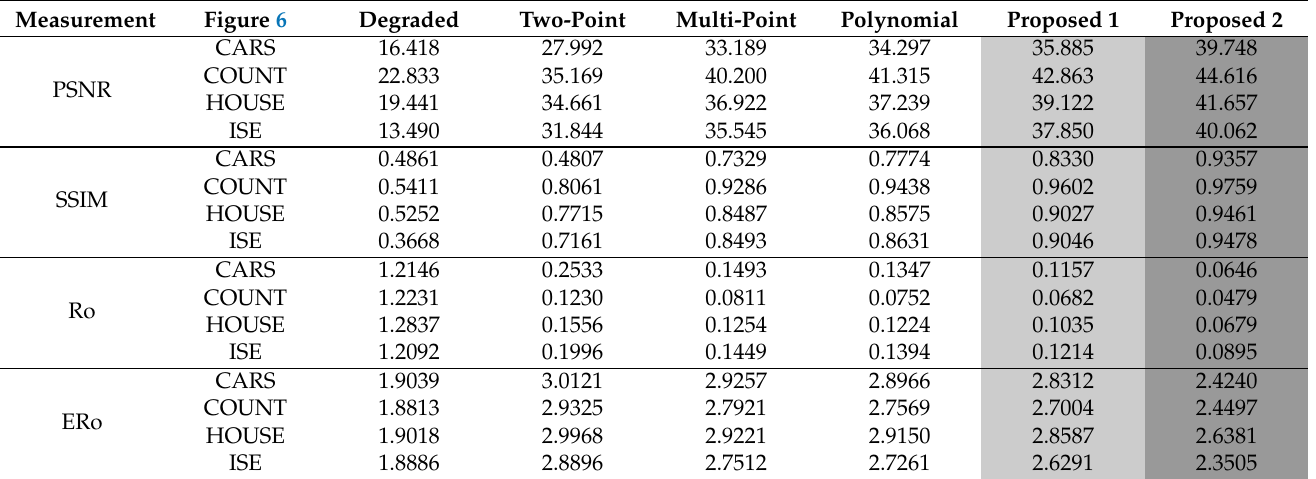
Table 1. Quantitative measurements of restored infrared image qualities of denoising algorithms using four quality assessments: PSNR, SSIM, Ro, and